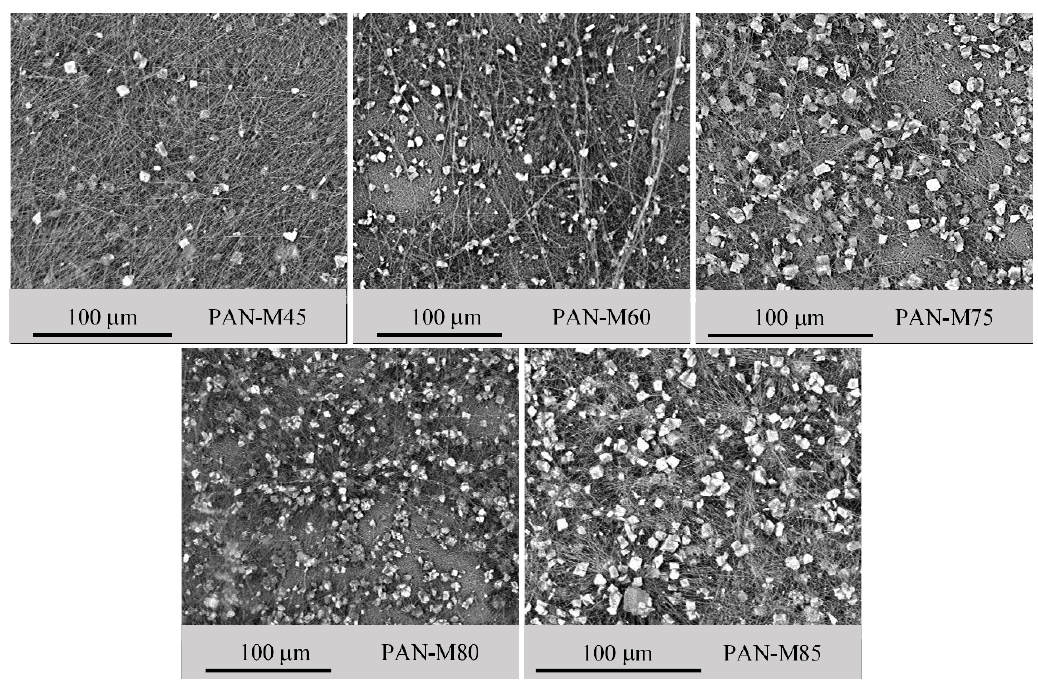
Figure 3. SEM images of PAN/SAPO-34M microfibers at increasing zeolite concentrations. The effect on the microfiber structure of increasing the zeolite concentration is more evident at higher magnifications, as shown in Figure 4, where samples PAN-M45, PAN-M75 and PAN-M85 are compared. At the lowest concentration of SAPO-34, the mean diameter of the microfibers was 0.68 m (measured by digital image analysis), similar to the diameter shown by microfibers of pure PAN